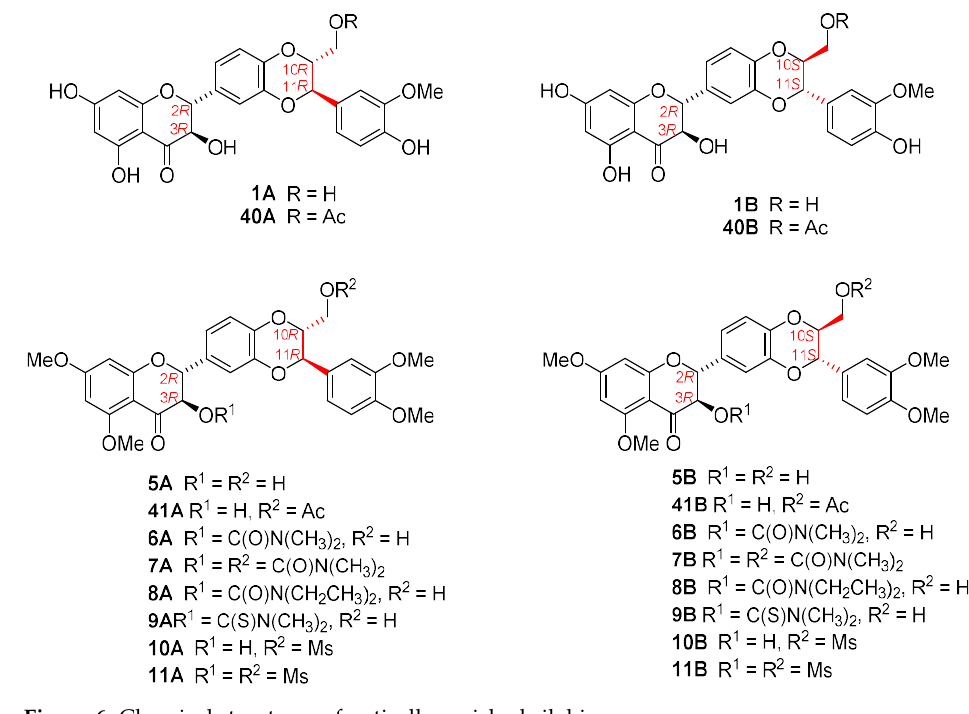
Figure 6. Chemical structures of optically enriched silybins.